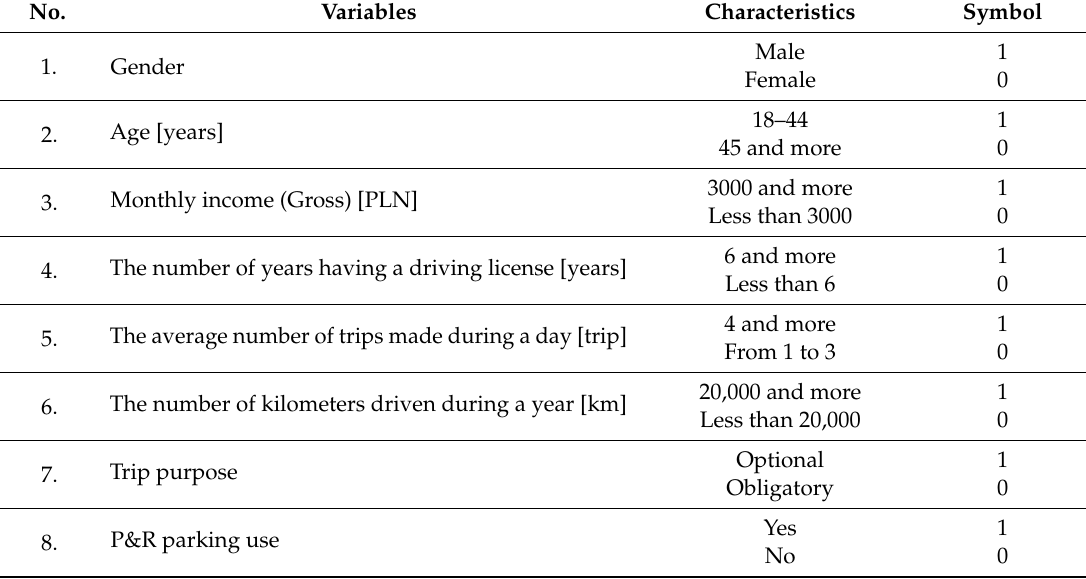
Table 4. Independent variables adopted for assessing the P&R parking